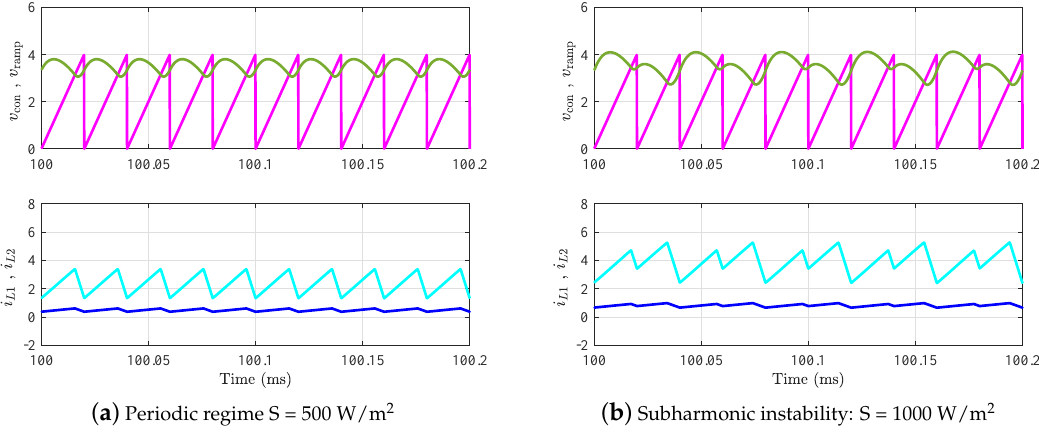
Figure 10. Close view of the ramp signal v ramp , the control signal v con , , and the inductor currents i L 1 and I L 2 at the DC-DC